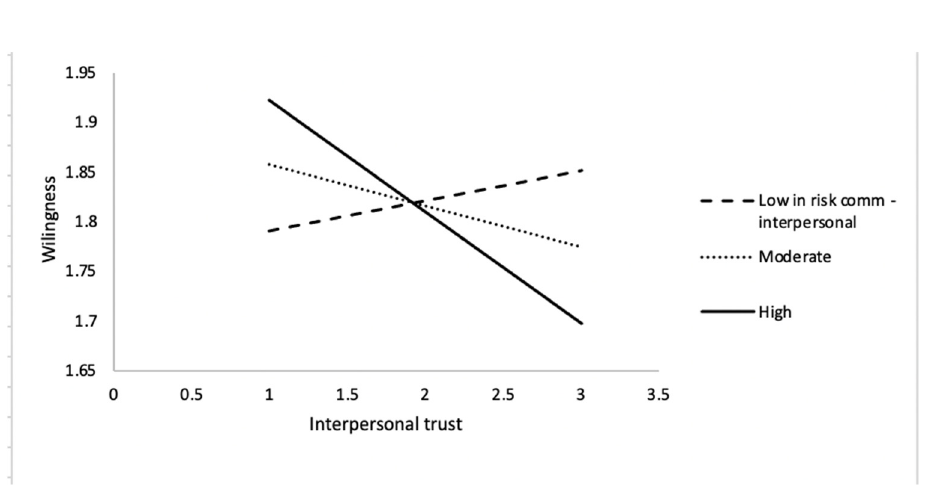
Figure 2. Willingness to socialize with others as a function of interpersonal trust and learning about the risks of COVID-19 from other people.